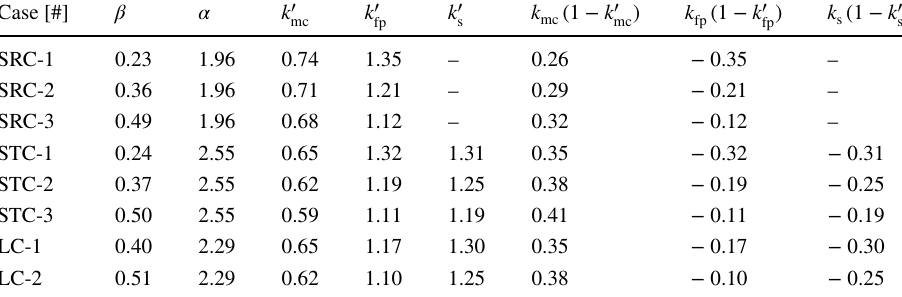
Table 3 Secondary flow coefficients for all test cases based on Devi and Khatua